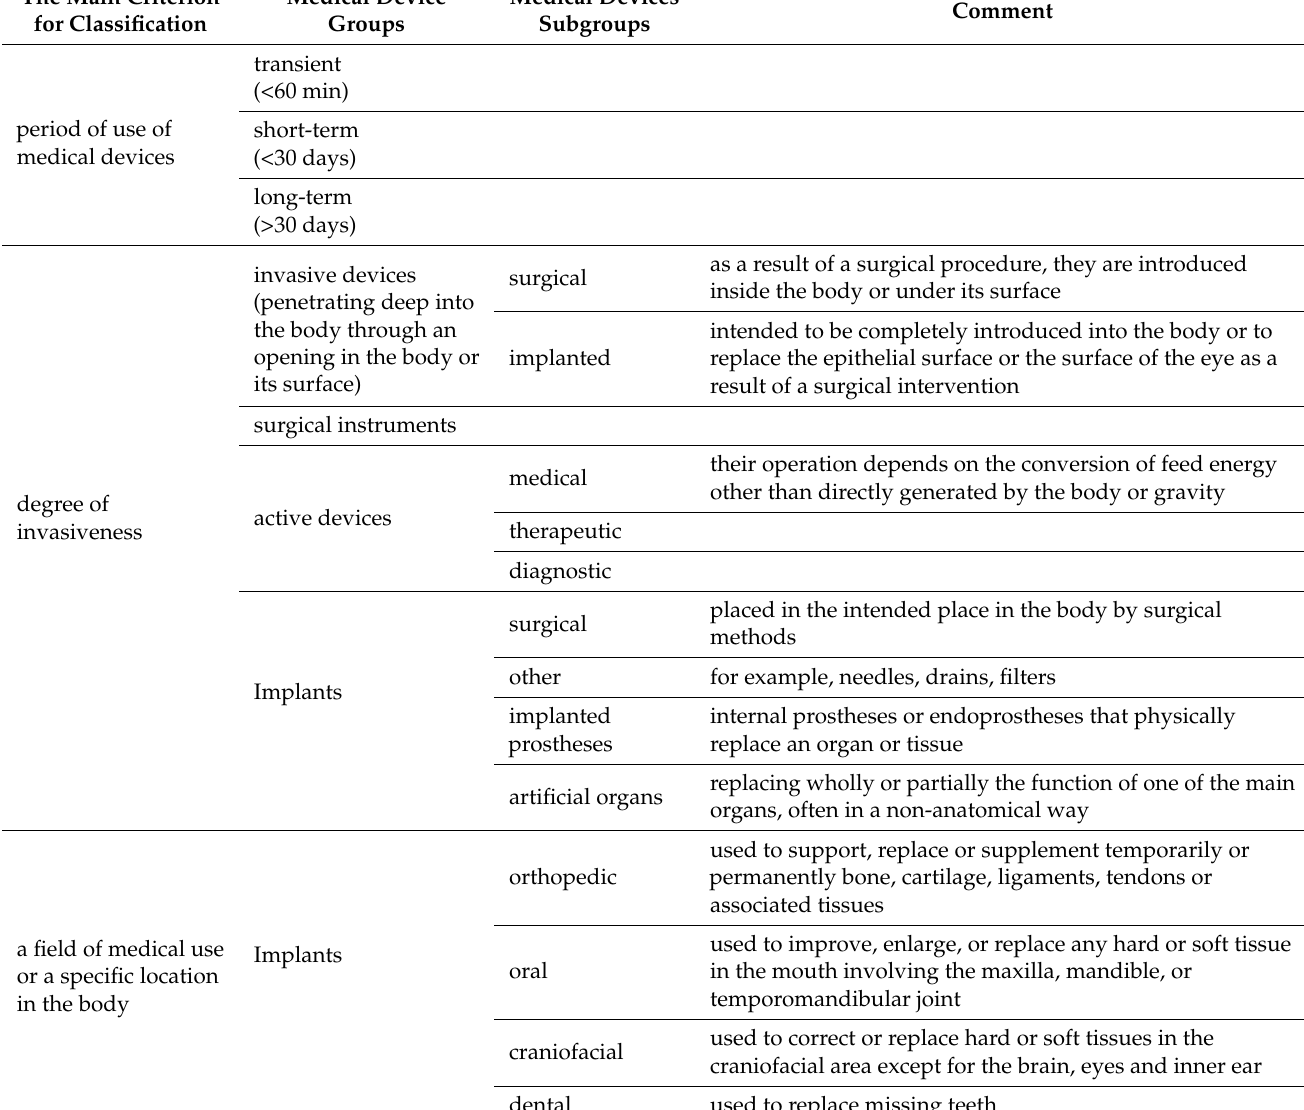
Table 2. The general classification of medical